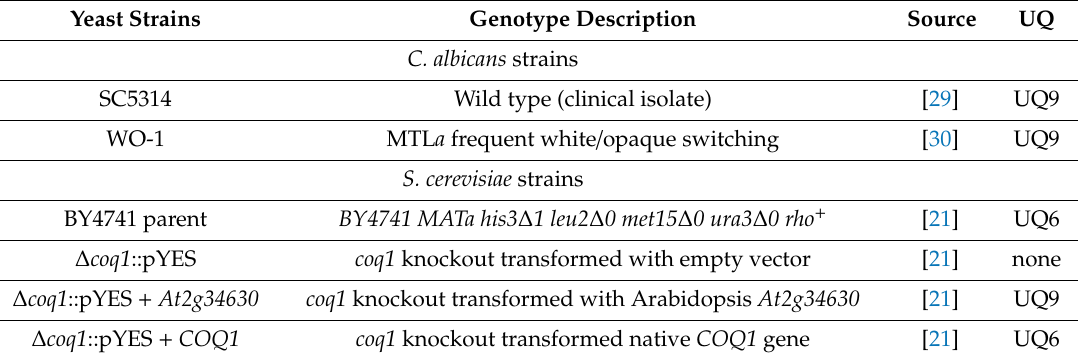
Table 1. Strains used in this